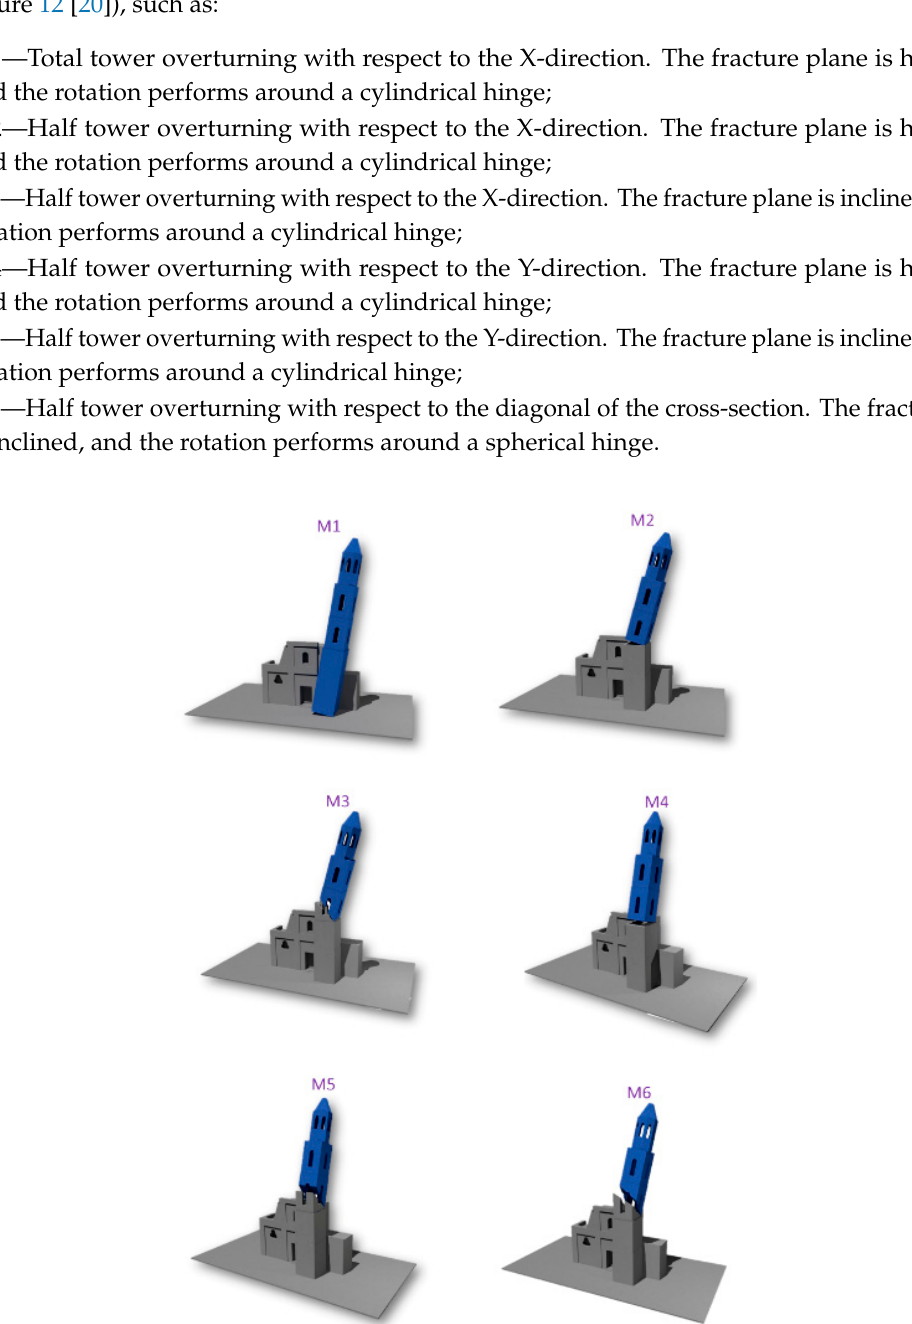
Figure 12. Draft of the failure mechanisms of the bell-tower.